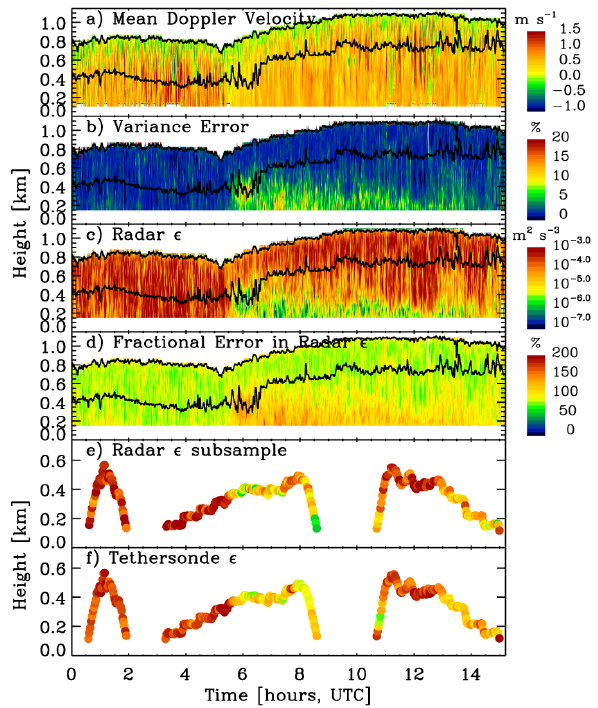
Fig. 1. Time-height contour maps of radar mean Doppler velocity (a) , fractional error in velocity variance from Eq. (6) (b) , radar- retrieved turbulent dissipation rate (c) , and fractional error in re- trieved dissipation rate from Eq. (7) (d) for a case from ASCOS on 28 August 2008. The retrieved dissipation rates are also sampled at the same 2-min time periods and heights (e) as the tethersonde dis- sipation rate measurements (f) . Dots in panels (e) and (f) follow the same colorbar as for panel (c) . Cloud liquid boundaries identified using ceilometer and cloud radar are plotted as black curves.